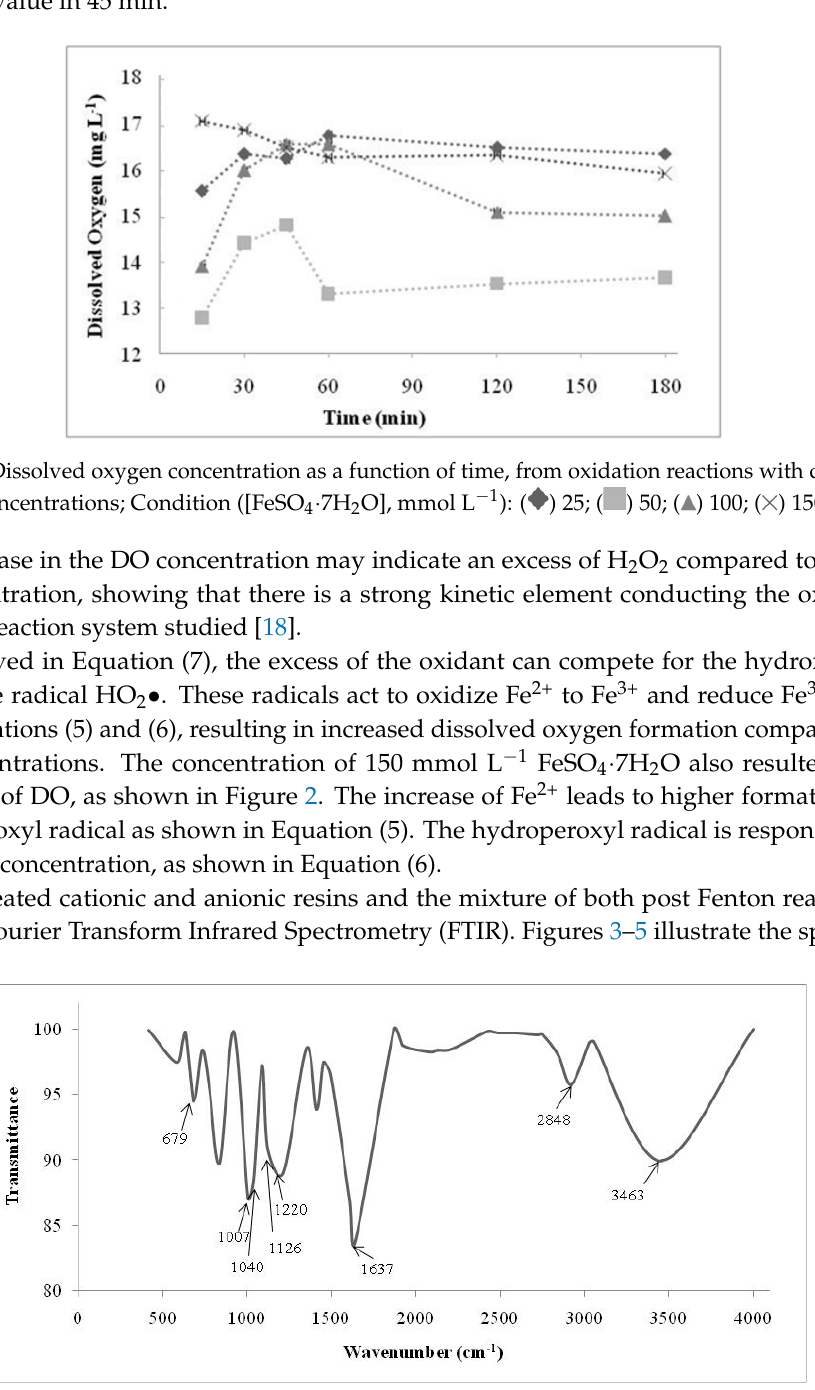
Figure 3. Infrared spectrum from strongly acid cationic resin.